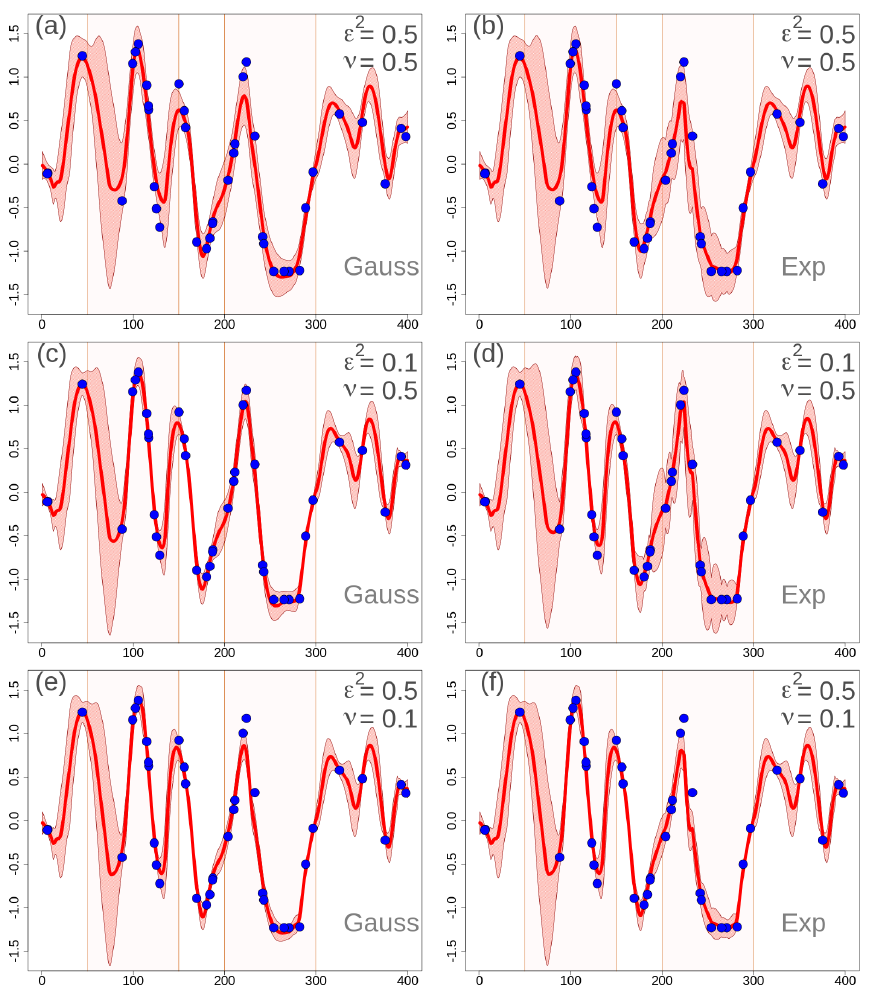
Figure 3. One-dimensional simulation in the transformed precipitation space. Analyses at grid points with different EnSI-GAP configura- tions. For all panels, L = 25u. The values of ν and ε 2 are reported in the panels. Specification of the scale matrix been obtained with a Gaussian function, while (b) , (d) , and (f) have been obtained with an exponential function. For each panel, the red line is the analysis (expected value), the pink shading shows the interval between the 90th and the 10th percentiles, and the blue dots are the observations as in Fig. 1b. The two regions, R1 and R2, have been highlighted with different shading in the background of each